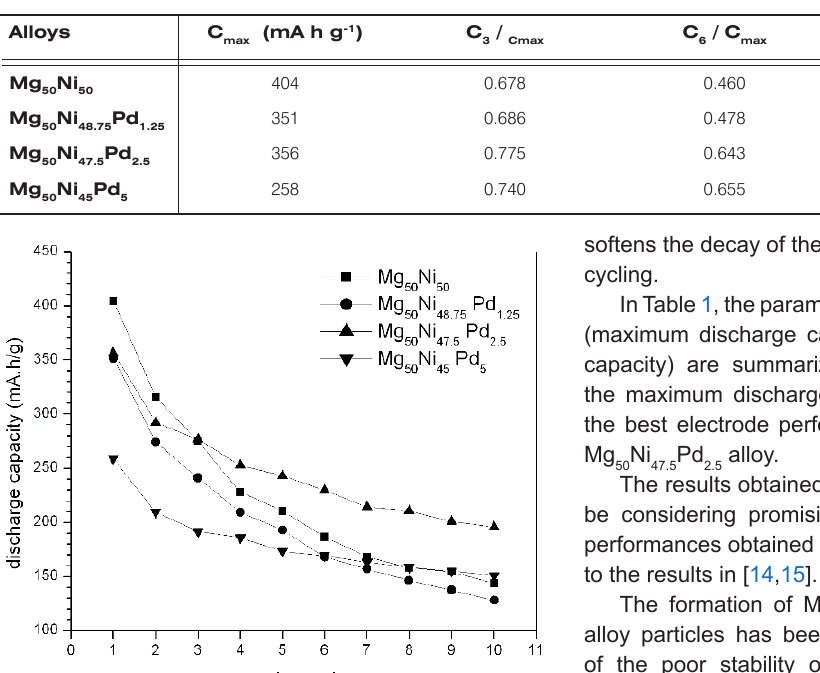
Figure 1. Discharge capacity versus cycling number for